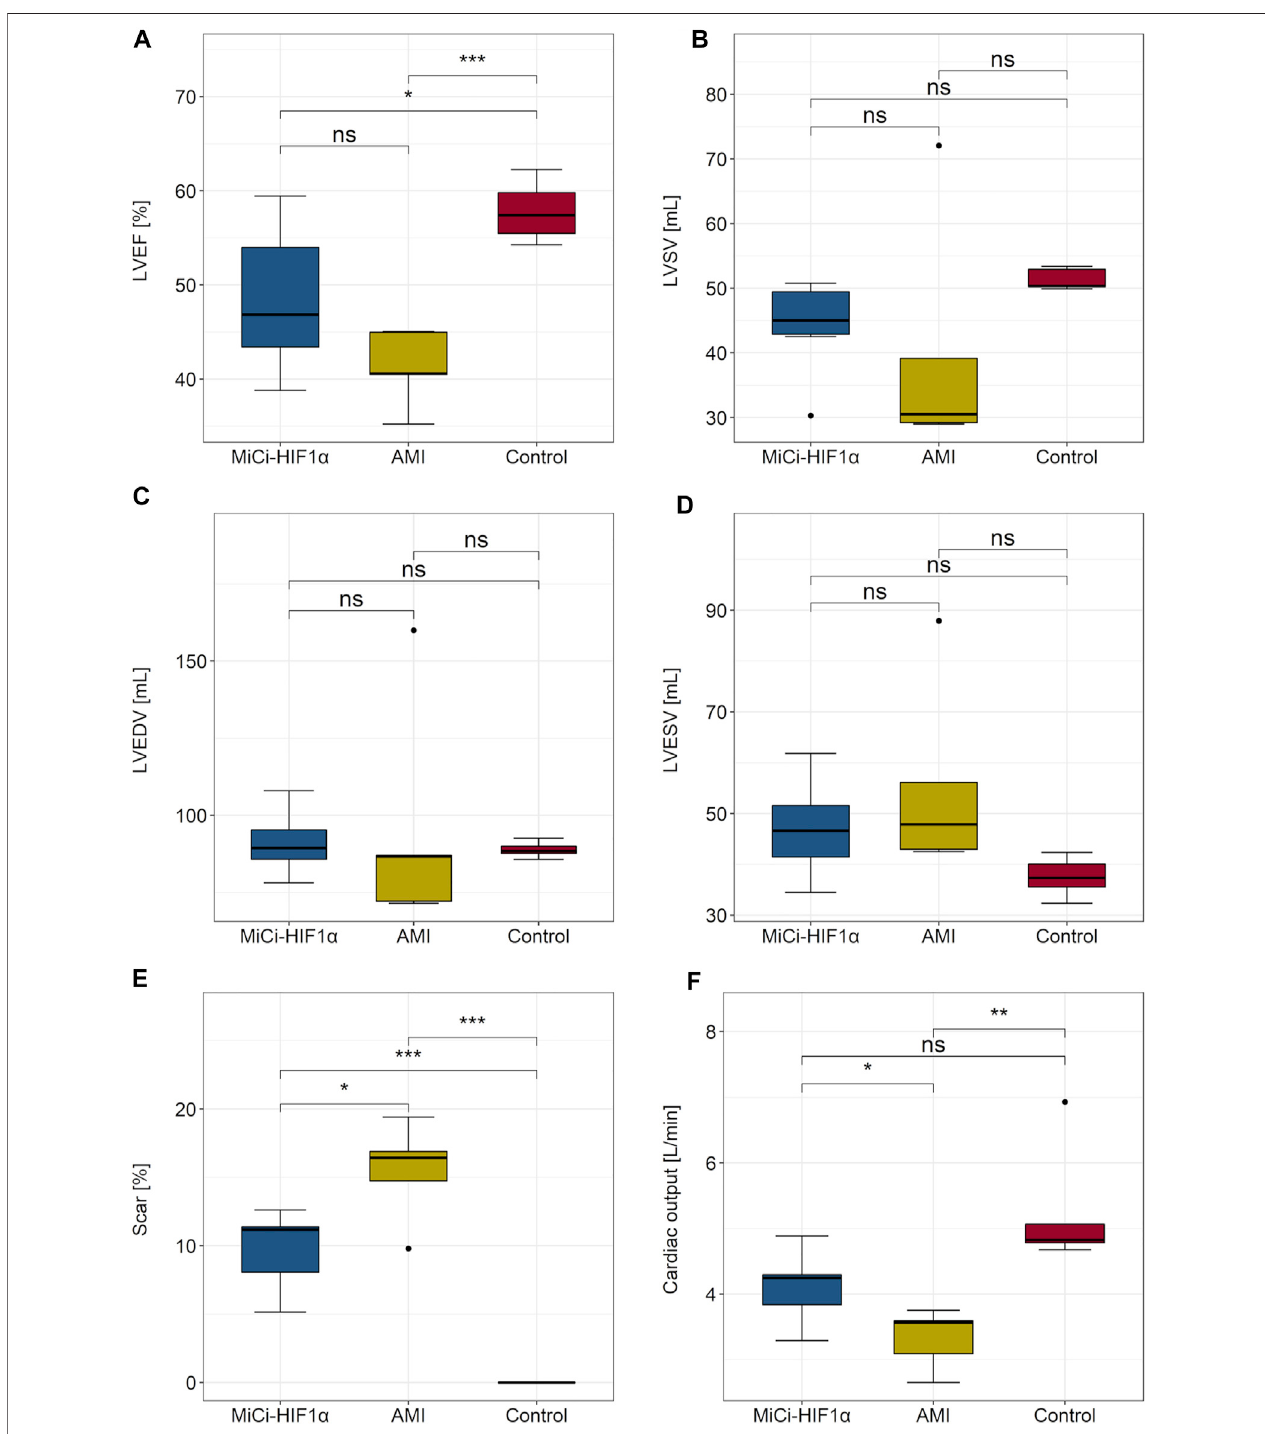
FIGURE 6 | Cardiac magnetic resonance imaging (cMRI) assessment of functional cardiac parameters. cMRIwith late gadolinium enhancement was performed 2 monthsafterinfarctionandone-monthpostpMSC-MiCi-HIF-1 α percutaneousintramyocardialdelivery.Resultsareshowninboxplotswithdotsrepresentingoutliers. (A) Left ventricular (LV) ejection fraction (EF), (B) LV systolic volume (SV), (C) LV end-diastolic volume (EDV), (D) LV end-systolic volume (ESV), (E) Myocardial infarct size, expressed as % of the LV, (F) Cardiac output (CO). Statistical signi fi cance was assessed by ANOVA and Bonferroni post-hoc test. ***: p < 0.001. **: p < 0.01, *: p < 0.05, ns: not signi fi